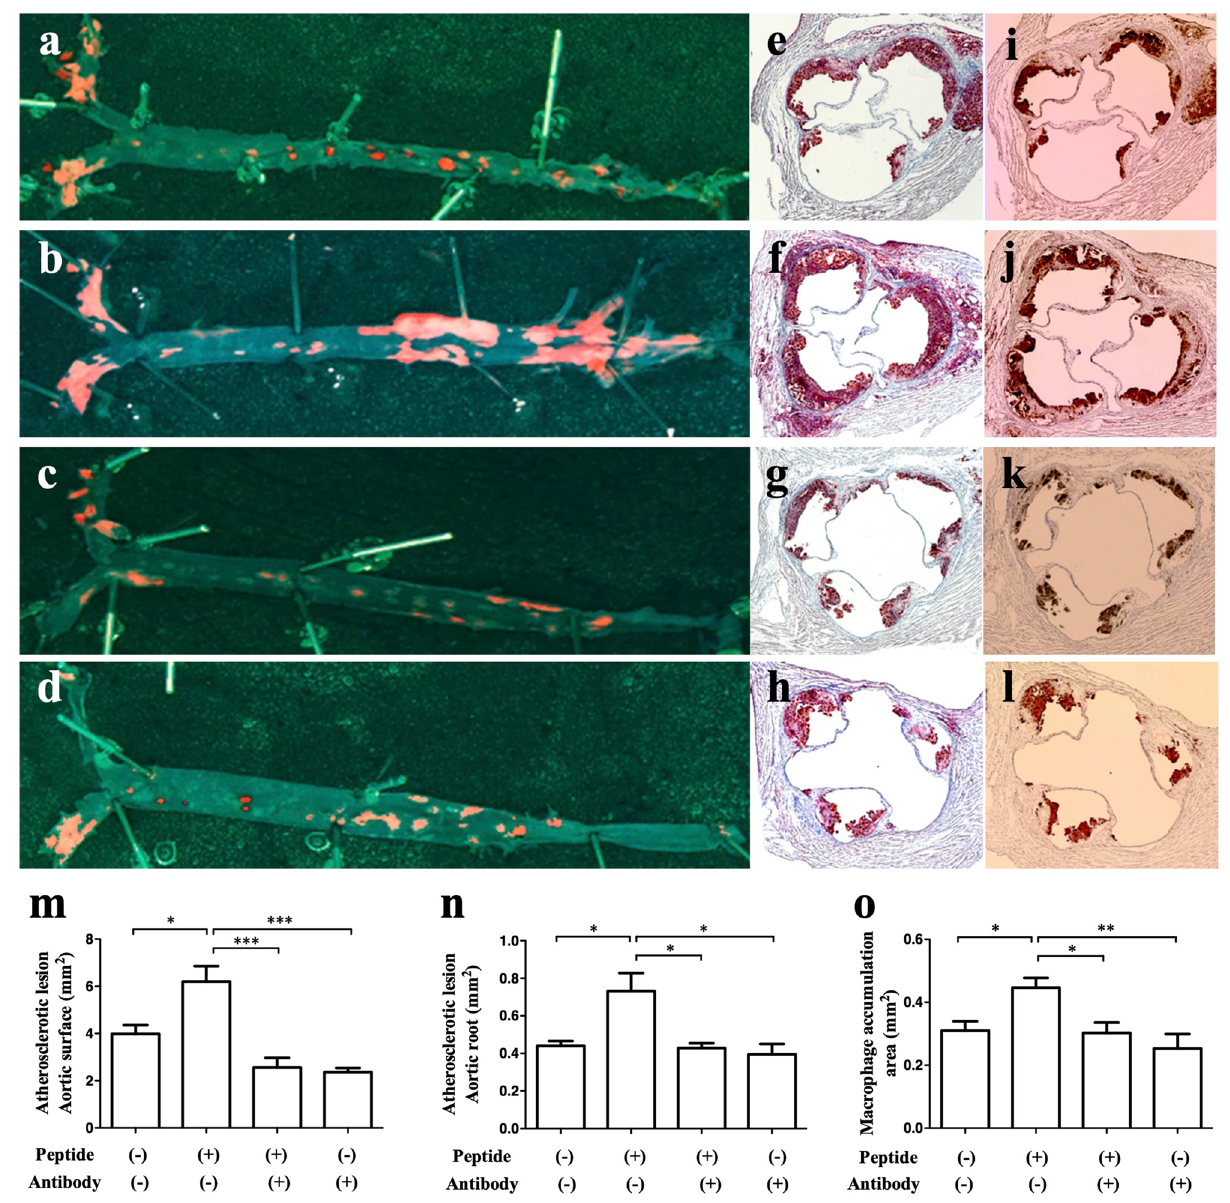
Figure 3. Proatherosclerotic effects of GIP_HUMAN[22–51] in ApoE −/− mice. The 17-week-old ApoE −/− mice were infused with saline alone ( a , e, and i , vehicle), GIP_HUMAN[22–51] ( b , c , f , g , j, and k , 0.6 nM/kg/h), and/or anti-GIP_HUMAN[22–51] IgG ( c , d , g , h , k, and l , 1.4 μg/kg/h) by osmotic mini-pumps for 4 weeks. The aortic surface was stained with oil red O ( a – d ). Cross sections of the aortic root were stained with oil red O ( e – h ) or anti-MOMA-2 antibody ( i – l ) and counterstained with hematoxylin. Surface area of the atherosclerotic lesions ( m ), cross sectional area of the atherosclerotic lesion ( n ), and macrophage accumulation ( o ) are expressed as means ± SEM ( n = 5–7). * p < 0.05, ** p < 0.01, *** p < 0.001 compared with